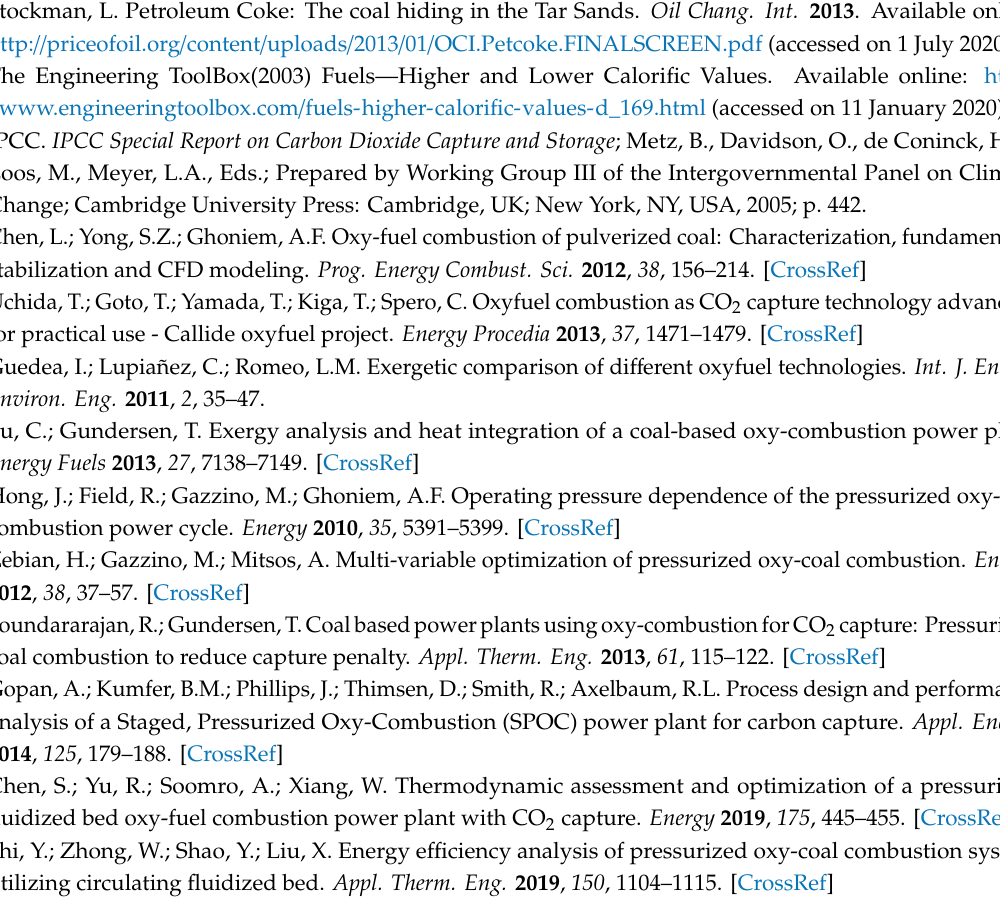
Figure S-1: Aspen Plus simulation flowsheet of the ASU, Figure S-2: Aspen Plus simulation flowsheet of the BOP, Figure S-3: Aspen Plus simulation flowsheet of the CO 2 CPU, Table S-1: Equipment description and material of construction for ASU, CBS, BOP and CO 2